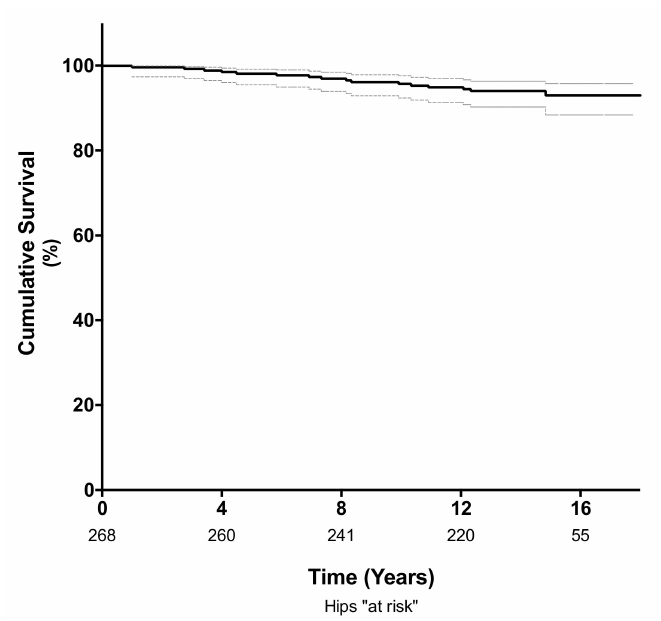
Figure 2. Kaplan-Meier analysis showing the survival free of revision for any cause was 96% (95% CI 92–98%) at 10 years and 94% (95% CI; 90–96%) at a mean follow-up of 14